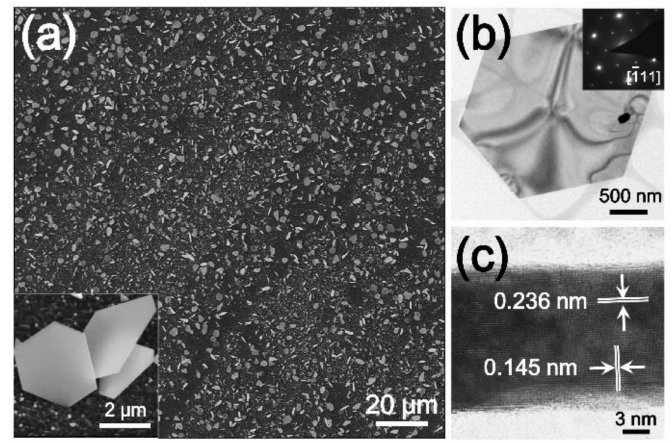
Figure 5. ( a ) SEM image of free-standing Au nanoplates synthesized on an FTO substrate. The inset is a magnified SEM image of the Au nanoplates; ( b ) TEM image and selected-area electron di ff raction (SAED) pattern (inset) of the Au nanoparticles; and ( c ) cross-sectional HR-TEM image of the Au